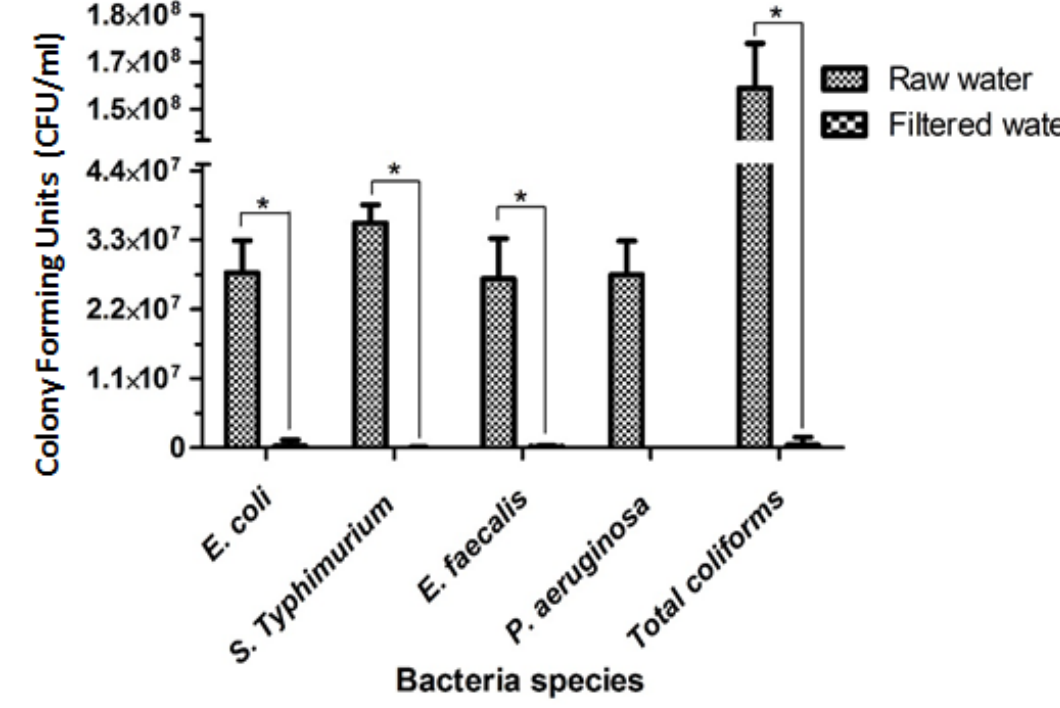
Figure 11. Concentrations of E. coli , S . Typhimurium, E. faecalis , P. aeruginosa , and TC of raw and filtered water.